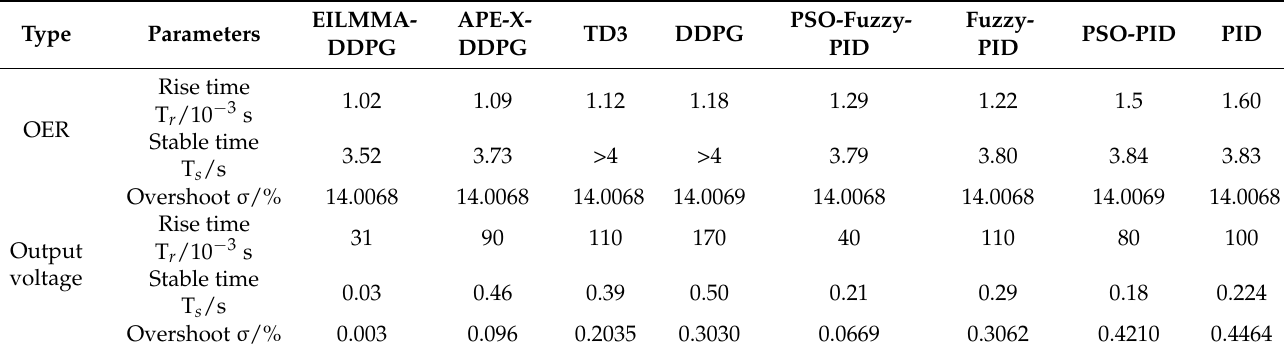
Table 2. Response parameters of PEMFC gas supply